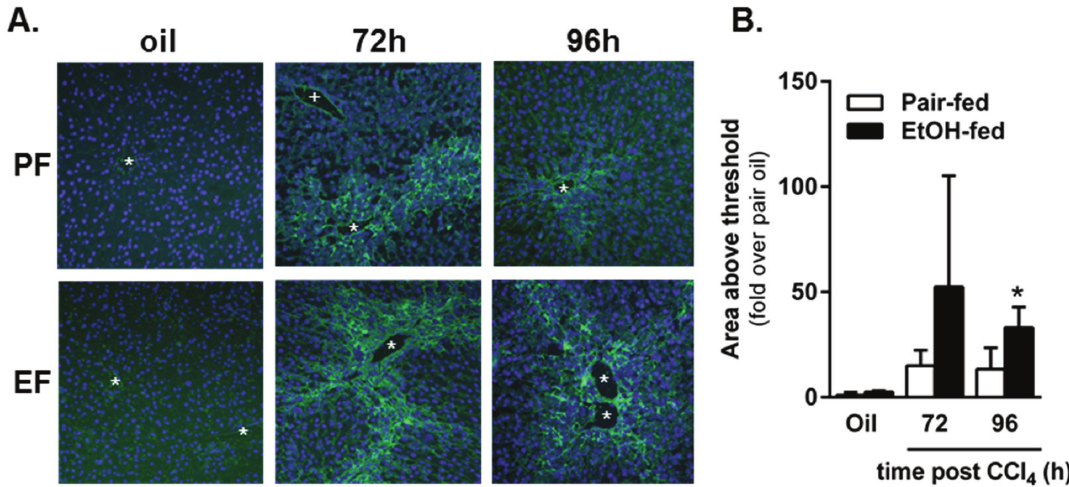
Figure 11. Matrix metabolism was sustained by ethanol feeding to mice after acute CCl 4 exposure. In situ zymography was used to determine area of gelatinase activity in frozen liver sections from pair- and ethanol-fed mice after CCl 4 exposure. ( A ) Representative fluorescence microscopy images. The green fluorescence indicates area of gelatinase activity. The blue fluorescence (DAPI) was used as a nuclear counter stain. The asterisks denote location of central veins, while the plus sign (PF, 72 h only) denotes the location of a portal vein. Matrix metabolism occurs most robustly in the pericentral area where CCl 4 -induced liver injury and subsequent liver regeneration occurs; ( B ) Quantification of the area of fluorescence per 200× image as a fold change over pair-fed, olive oil-treated mice. PF = Pair-fed, EF = Ethanol-fed. N = 3–6 mice per group (CCl 4 ). * (in B ), p < 0.05.